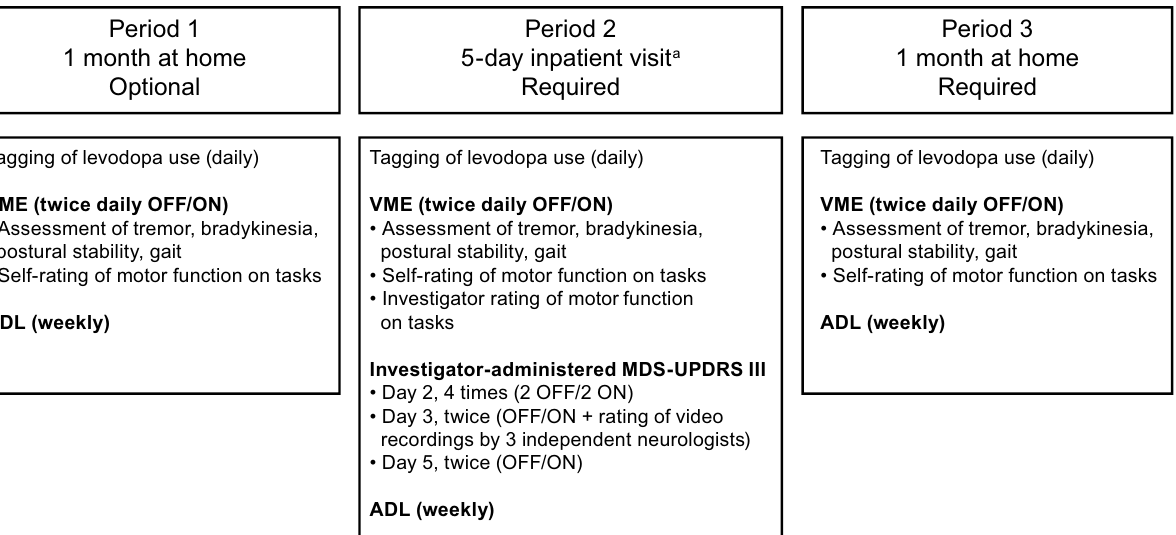
Figure 2. Study design. Period 1 was optional to accommodate the most flexible schedule for patients. Patients could enroll in the study before Period 1 in an outpatient clinic or immediately before or during Period 2. At enrollment, patients were screened for eligibility, provided written informed consent, received the smartwatch, and underwent baseline study assessments. During Period 2, patients were washed out of all concomitant Parkinsonian medications. At the final outpatient clinic visit, patients underwent final assessments and returned the smartwatch. The duration of each period may have varied from the specified durations due to the convenience of having the device dispensed and returned at the study site, the timing of the patient’s scheduled visit, and the length of the hospital stay depending on their individual treatment needs; all available data were included in the analysis regardless of the duration of each period. The VME, comprising seven structured motor tasks, was conducted at scheduled times representing relatively poor symptom control (when medication was wearing off [OFF]) and good symptom control (when medication was working well [ON]). a During the 5-day inpatient period, patients could undergo an optional 2 days of assessments, which were not included in the study. ADL activities of daily living, MDS-UPDRS Movement Disorder Society-sponsored revision of the Unified Parkinson’s Disease Rating Scale, VME virtual motor examination.